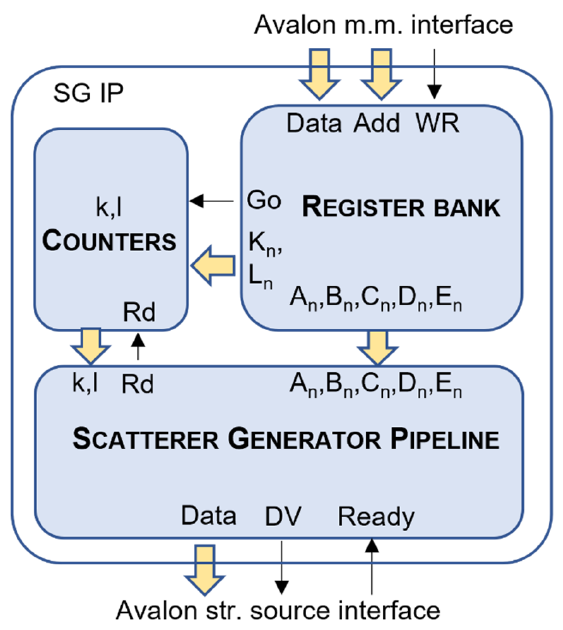
Figure 2. Scatterer generator integrated in the SG IP with input/output interfaces and counters for the l, k indexes.